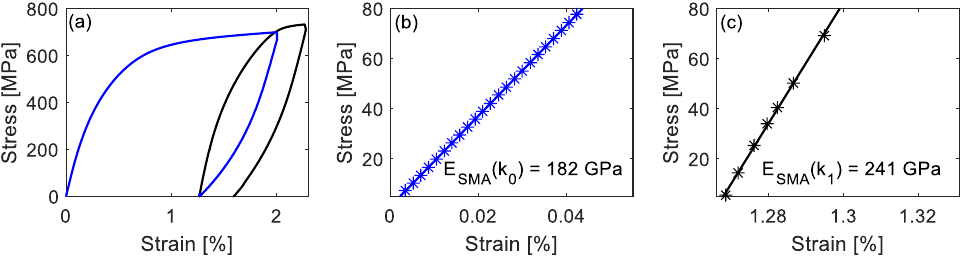
Figure 7. ( a ) Stress as a function of strain during pre-straining (blue) and re-loading (black); ( b ) the linear fitting (regression line) in 5–80 MPa of pre-straining; ( c ) the linear fitting (regression line) in 5–80 MPa of re-loading.